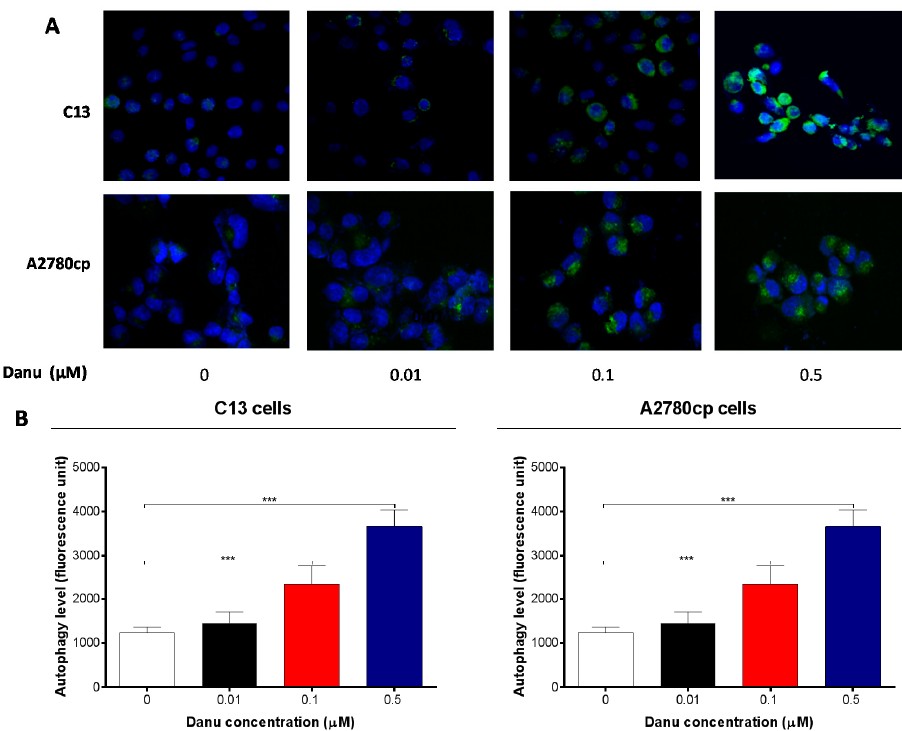
Figure 10. Danu induces autophagy in C13 and A2780cp cells determined by confocal microscopy. C13 and A2780cp cells were incubated with Danu 0.01, 0.1, and 0.5 μ M for 24 h and then subject to confocal microscopy. ( A ) Representative images showing autophagy of C13 and A2780cp cells and ( B ) bar graphs showing the percentage of autophagic C13 and A2780cp cells. Data represent the mean ± SD of three independent experiments. Magnification: 60×; scale bar: 5 μ m. *** p < 0.001 by one-way analysis of variance.